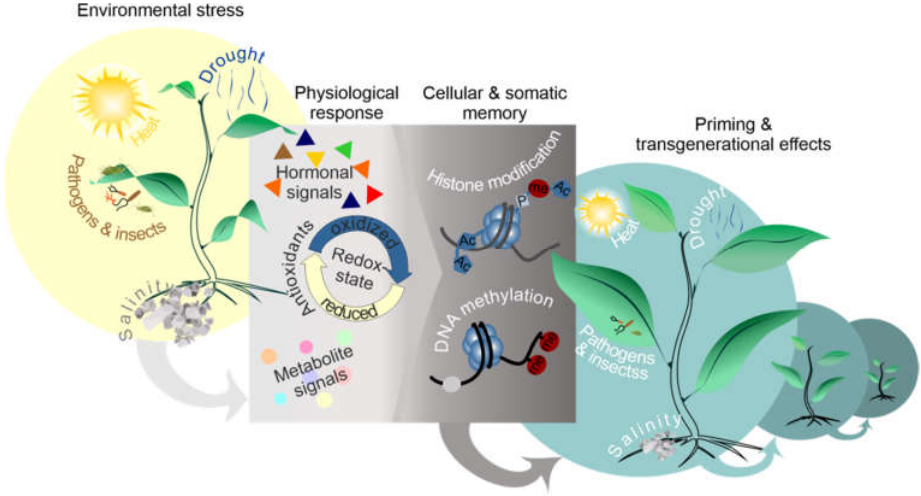
Figure 2. Diagrammatic overview of the environmental and physiological factors involved in priming and transgenerational effects. Priming is caused by environmental and physiological factors (antioxidants, redox state, hormonal crosstalk, metabolites